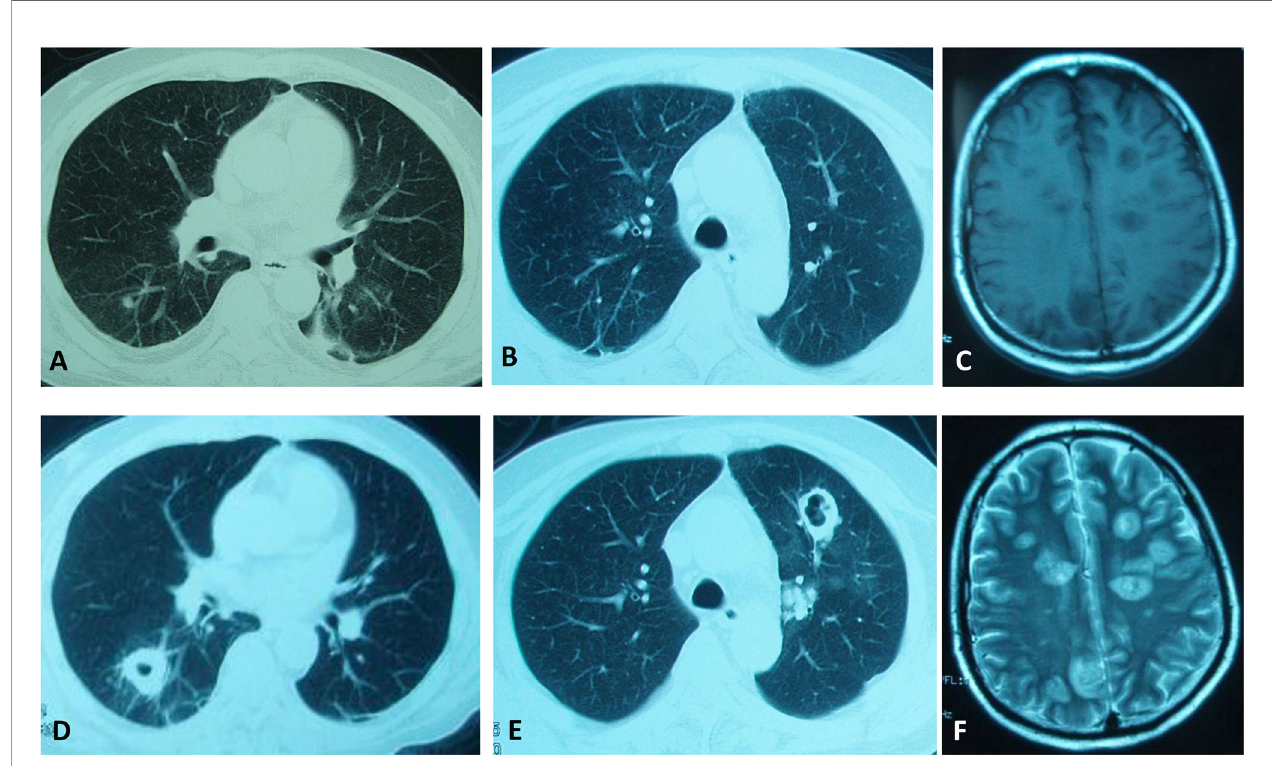
FIGURE 1 | Clinical images of our patient. CT scanning of the chest showing continuous development to a large cavitary mass in both lung lobes. (A, B) were taken on the 6 th day. (D, E) were taken on the 15 th day. (C, F) MRI scanning showing multiple long T1/T2 signal lesions in the brain on the 24 th